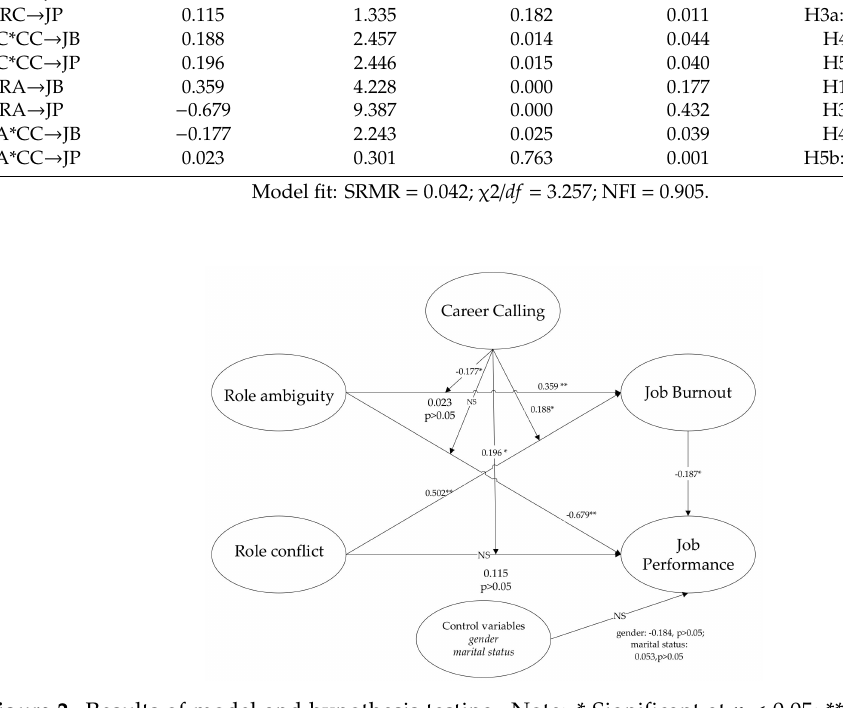
Figure 2. Results of model and hypothesis testing. Note: * Significant at p < 0.05; ** Significant at p < 0.01; NS indicates not